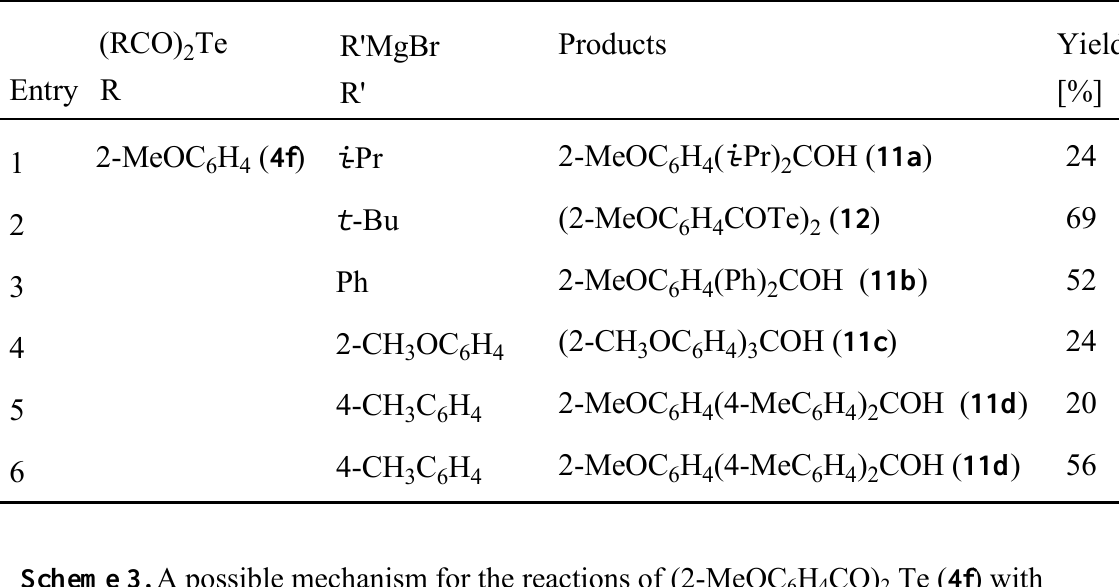
H CO) Te ( 4f ) with 6 4 2